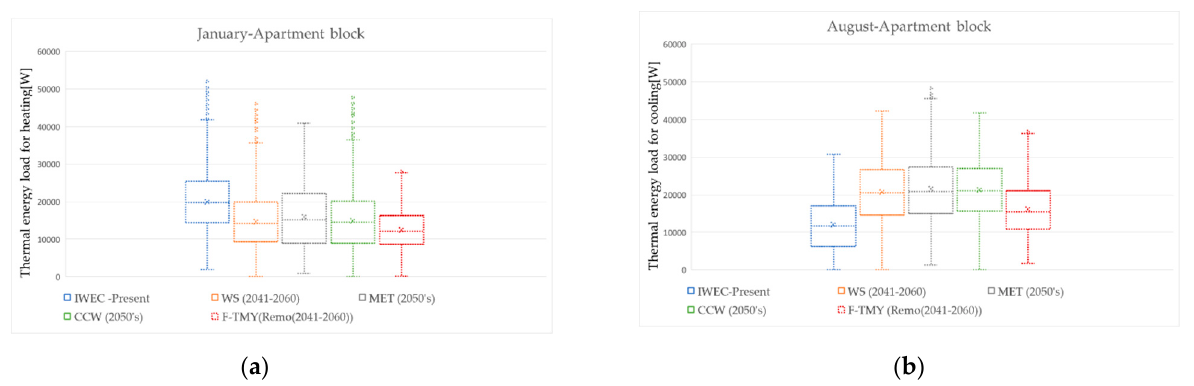
Figure 5. Boxplots of heating loads in January ( a ) and cooling load in August ( b ) of the apartment block for IWEC (Present), Weathershift (WS), Meteonorm (MET), CCWorldWeatehr-Gen (CCW), and F-TMY. All future weather files are for 2050s considering RCP 8.5.